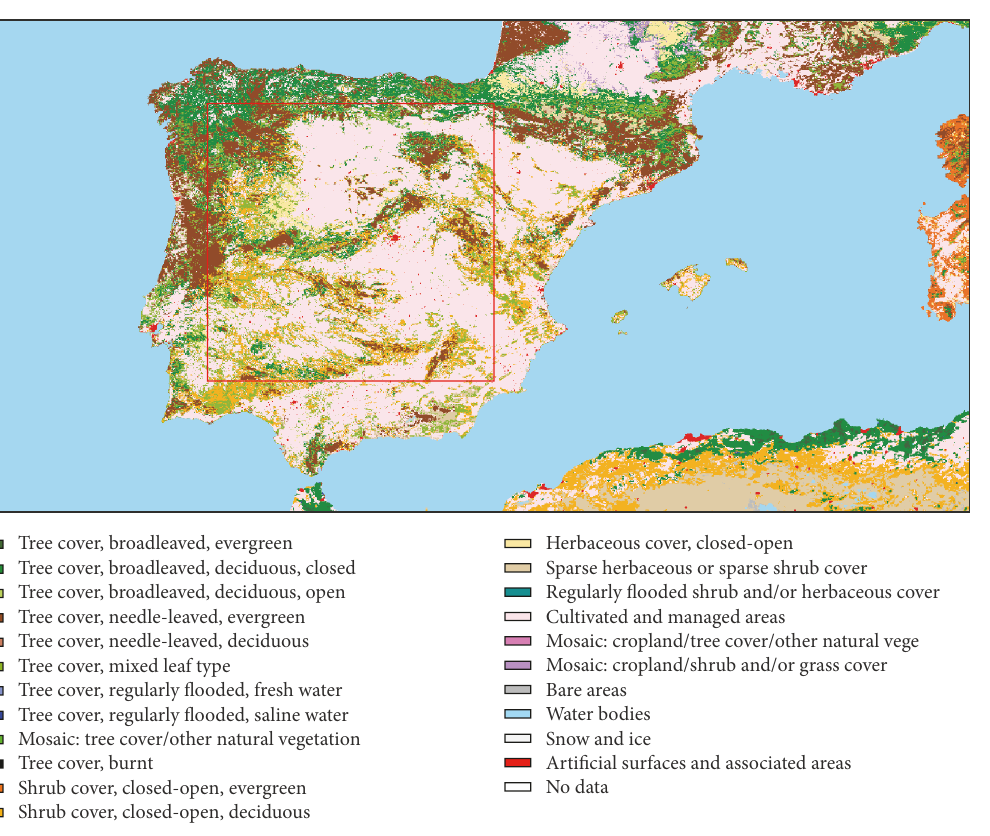
Figure 1: Land surface covers in study area with a resolution of 1 kilometer generated from the Global Land Cover 2000